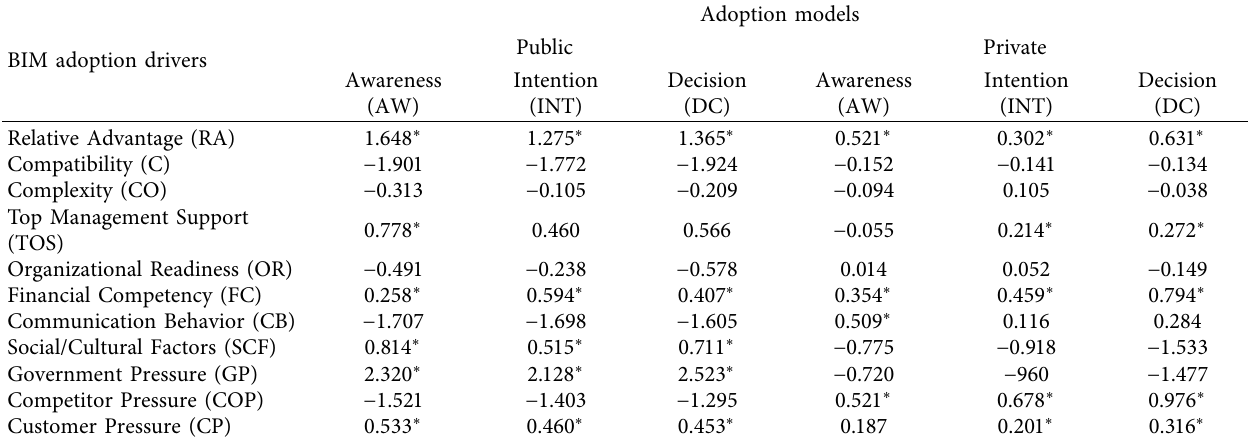
Table 11: Summary of hypothesis testing results for both public and private structural